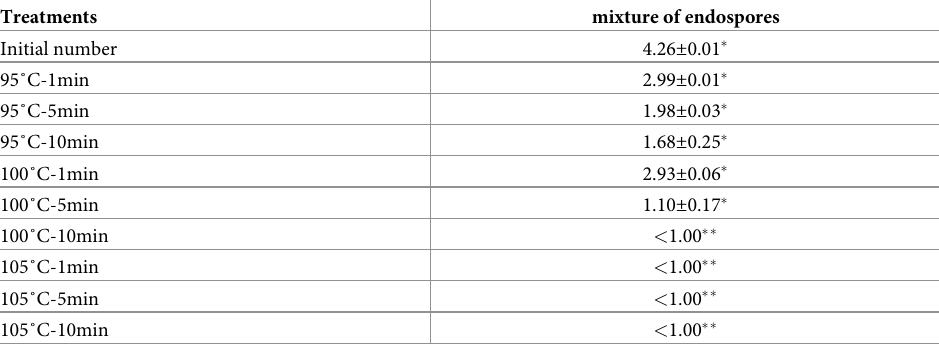
Table 4. Effect of microwave treatments on Bacillus endospores inoculated in Tilia tomentosa extract.